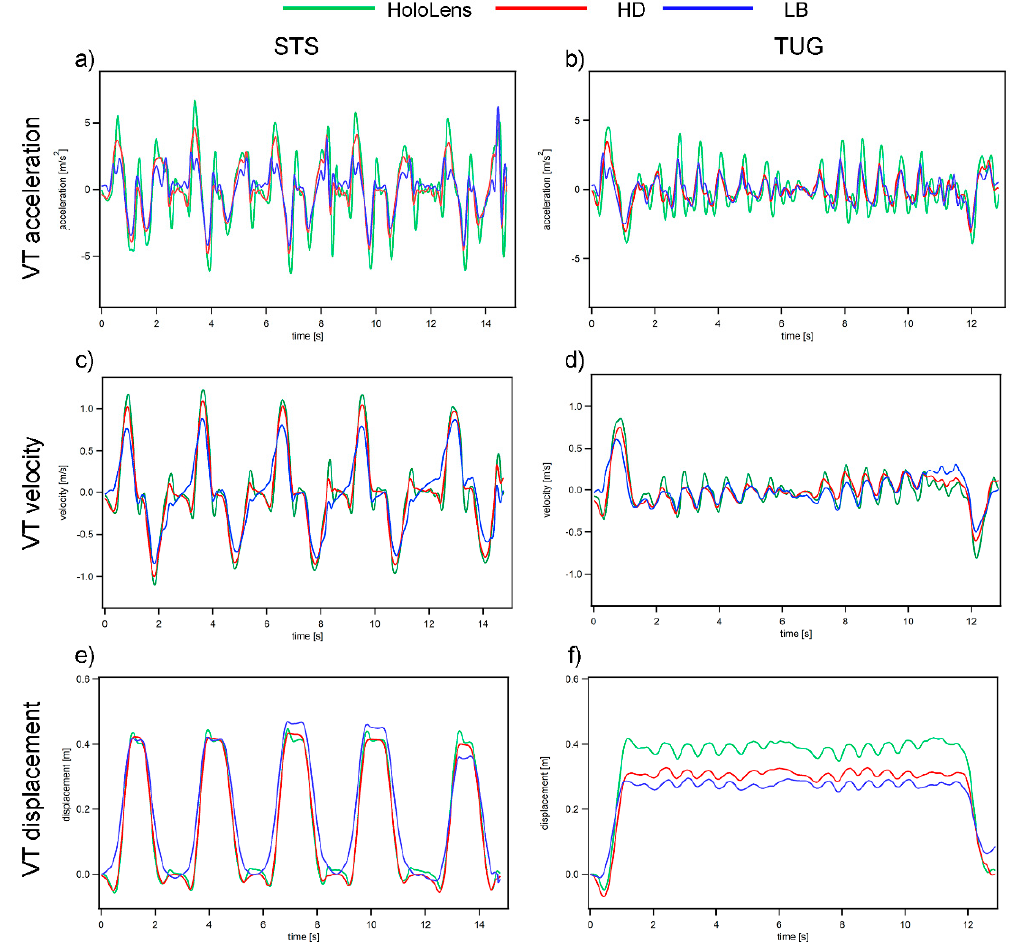
Figure 2. Sample kinematic profile from a young participant. Green denotes HoloLens, red denotes HD sensor, and blue denotes LB sensor. ( a , b ) VT acceleration profile from the STS and TUG tasks; ( c , d ) VT velocity profile from the STS and TUG tasks; and ( e , f ) VT displacement profile from the STS and TUG tasks.